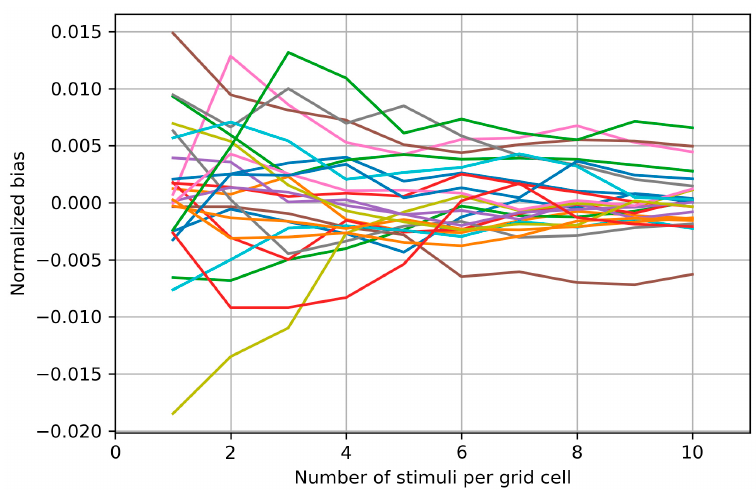
Figure A5. Bias of the area weighted by the probability of a suprathreshold MEP for all sessions of all subjects.